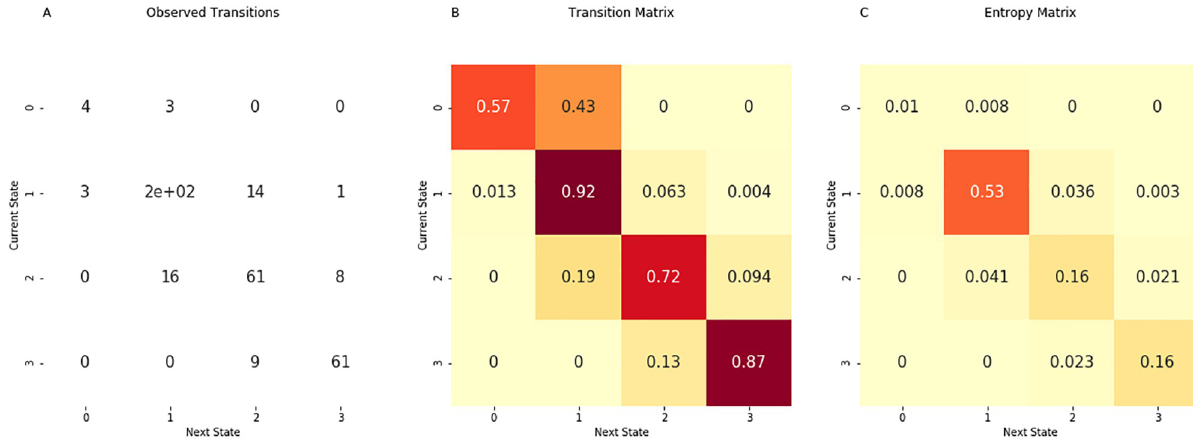
Fig 2. Matrix construction. We counted how often a transition to any illness state occurred for each of the four illness states. The count information is displayed in (A). In the Markov chain transition matrix (B), the probabilities are obtained by dividing the counts by the total number of observations from each initial illness state. In the ‘entropy matrix’ (C), the probabilities are obtained by dividing the counts by the total number of observed transitions. Thus, values in the entropy matrix indicate the density of the observed transitions. The visual difference between the transition and entropy matrices arises from the fact that the row values sum to one in the transition matrix while all the cell values sum to one in the entropy matrix. The figure may be interpreted as follows. The darkest cell in the entropy matrix (c) is in the second row and the second column, where 53% of observed transitions occurred. The corresponding cell in the transition matrix (B) signifies that 92% of the time the patient was in illness state 1, he remained in illness state 1.